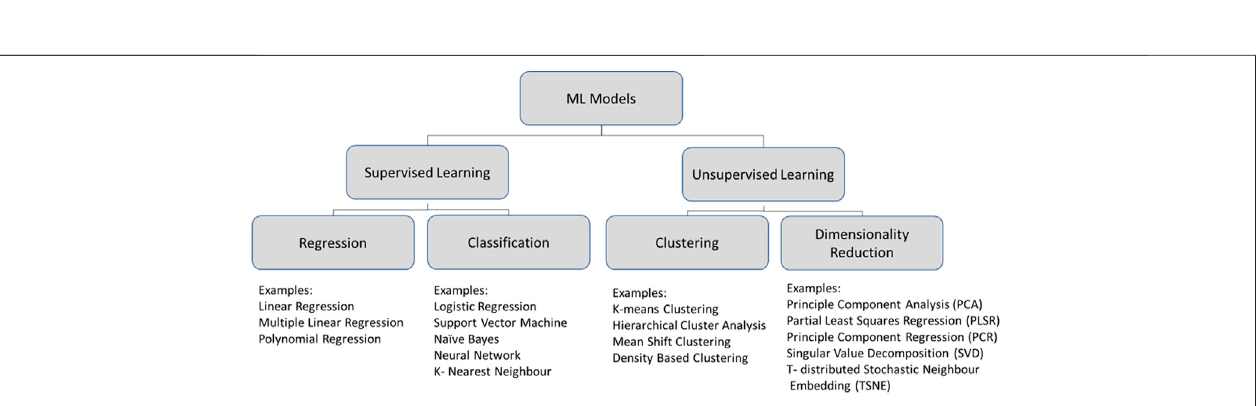
FIGURE 3 | Simple guide to the machine learning (ML) approach which we propose be applied to systems astrochemistry.